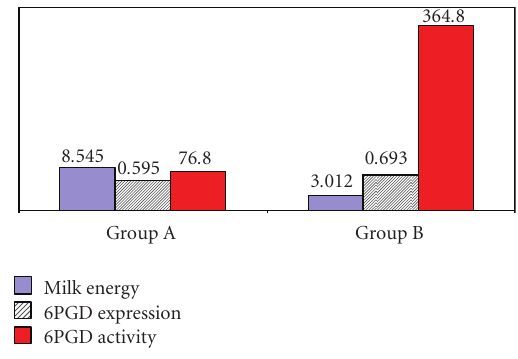
Figure 2: Correlation among enzymatic activity (nmol NADPH/10 6 adipocytes), gene expression of 6PGD and milk energy (Mj) of lactating